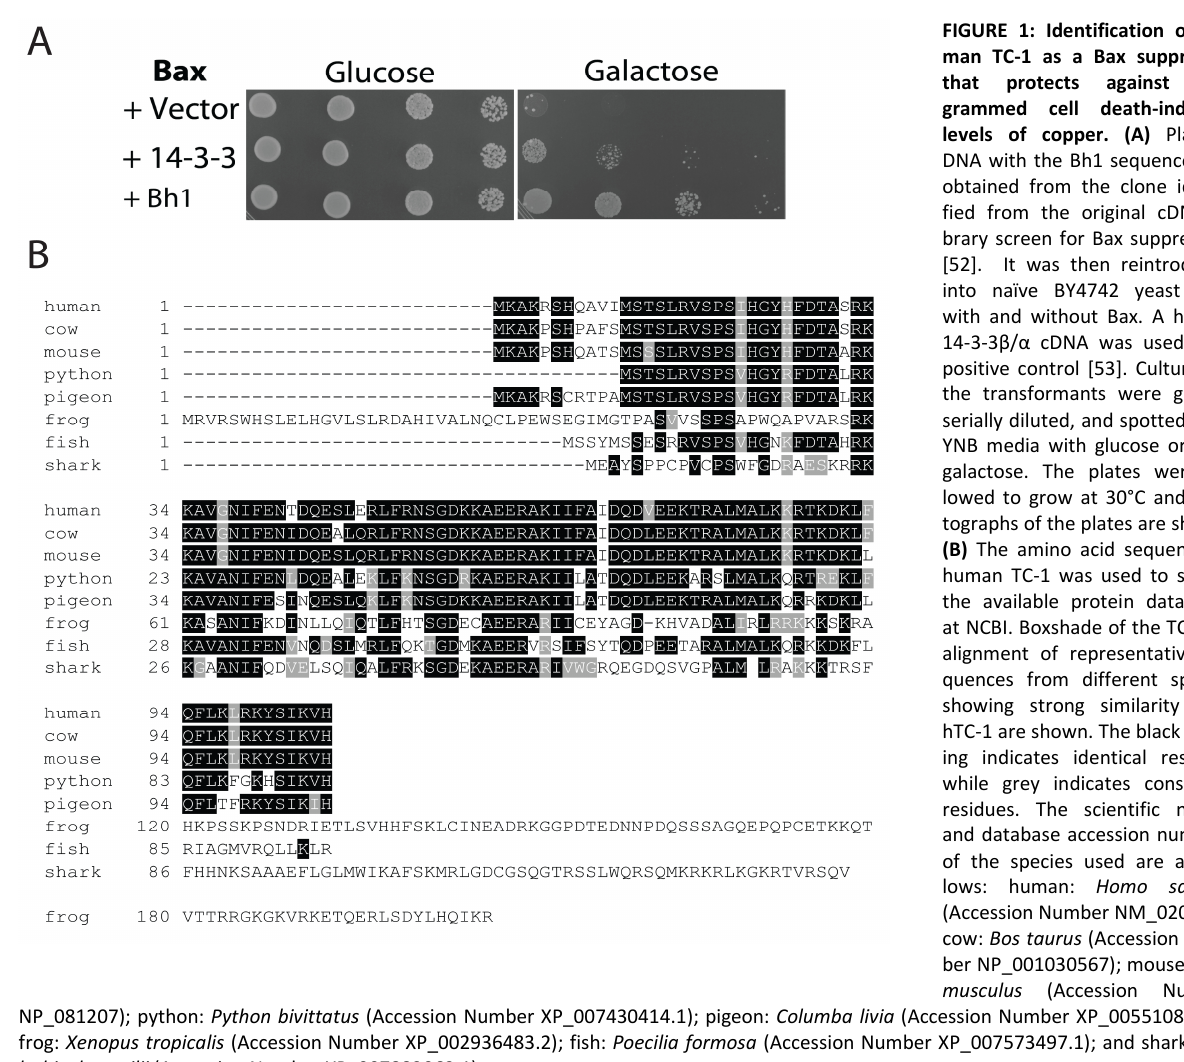
FIGURE 1: Identification of hu- man TC-1 as a Bax suppressor that protects against pro- grammed cell death-inducing levels of copper. (A) Plasmid DNA with the Bh1 sequence was obtained from the clone identi- fied from the original cDNA li- brary screen for Bax suppressors